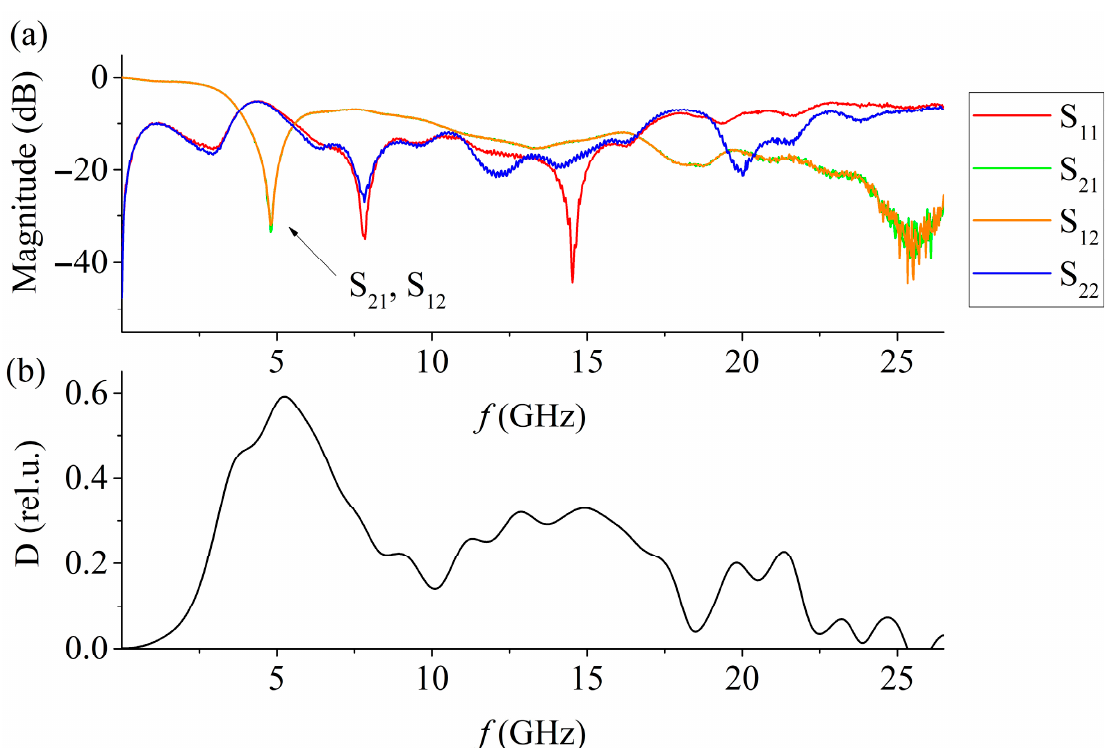
Figure 3. The dependence of the S-parameters ( a ) and the absorption coefficient ( b ) of the MSL with the sample on the frequency.